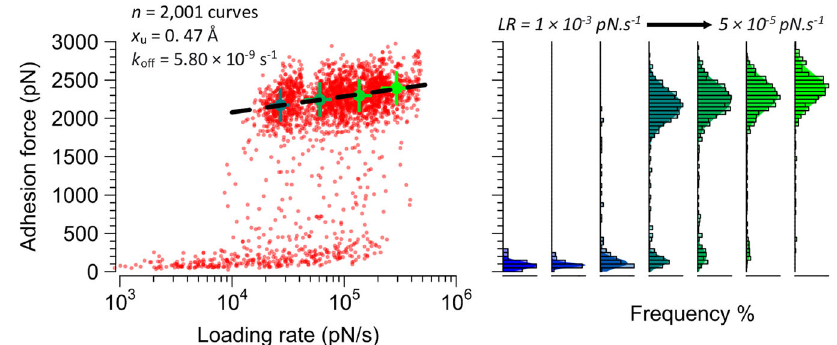
Fig. 3 Mechanical stress activates the extremely strong FnBPB-loricrin interaction. Left: dynamic force spectroscopy plot of rupture force vs loading rate ( n = 2305 curves from six cells). The dotted lines show the extrapolated Bell-Evans fi t through the most probable (mean) rupture forces and loading rates for four log-equispaced loading rate bins shown as solid circles. Error bars are the standard deviations. Right: corresponding histograms and Gaussian fi ts of